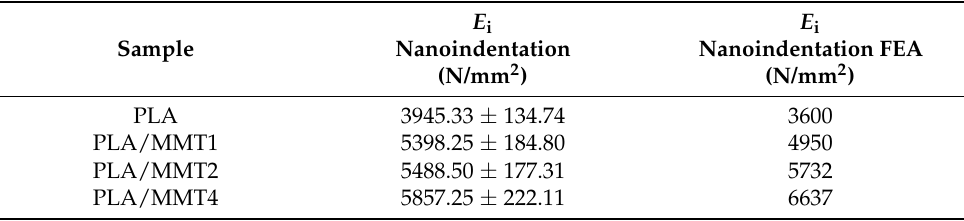
Table 8. Comparison of elastic moduli of nanoindentation of PLA and PLA/MMT.